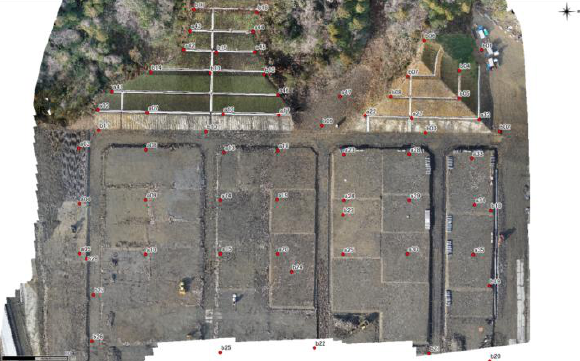
Figure 2. Work area construction site; numbers beginning with a or b indicate test targets.